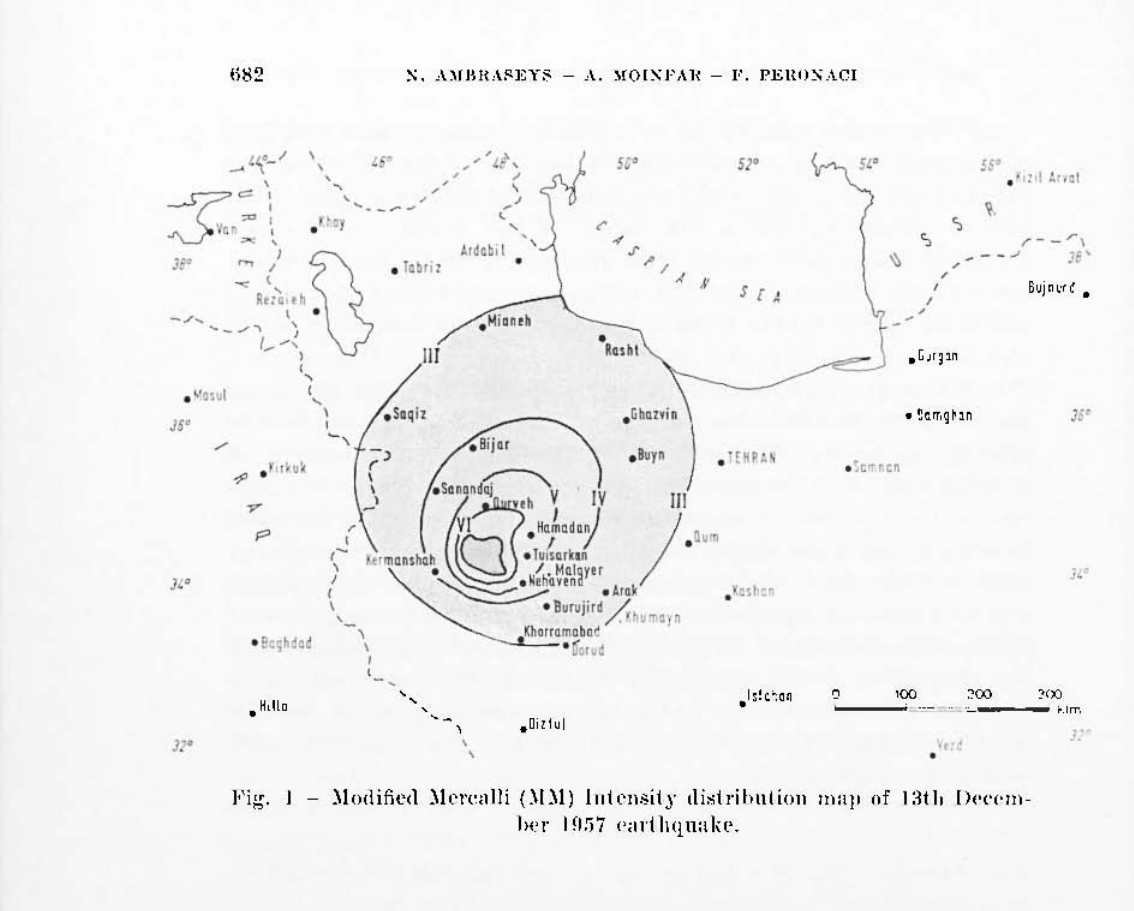
Fig'. J - :llodific(! :l1t'l'ealli ODI) Intt'nsi/y lli~trihll(ion maJl of 1:1t11 [)('l'('m- 1)('1' In,ii